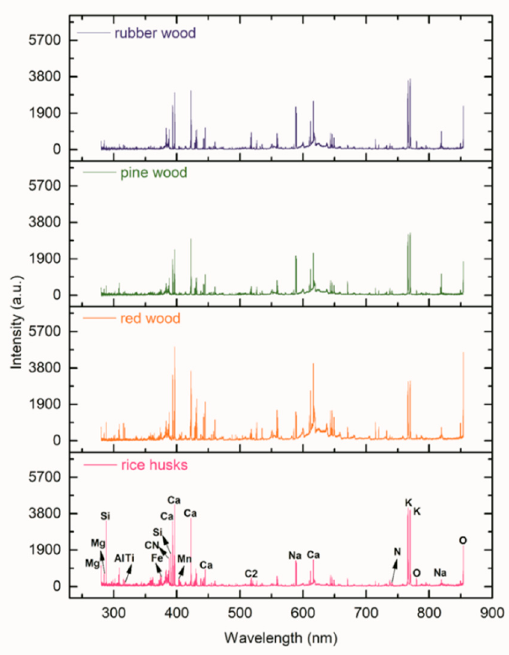
Figure 3. Spectra of the four categories of biomass pellets in 280.25–854.12 nm. Table 3. Prediction results of chemometric